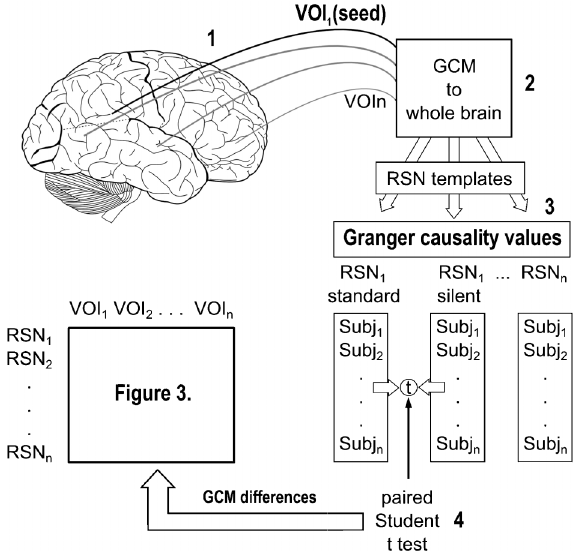
Figure 1. General scheme showing the approach of our data analysis. Numbers stand for 1 = seed definition based on between-group ICA differences; 2 = Granger causality values calculation across whole brain voxels; 3 = Granger maps and RSN templates overlapped; 4 = paired t -test for GCM differences between noise conditions and across subjects (see Figure 3). VOI = volume-of-interest; Subj = subject; RSNs = resting-state networks; GCM = Granger causality mapping.